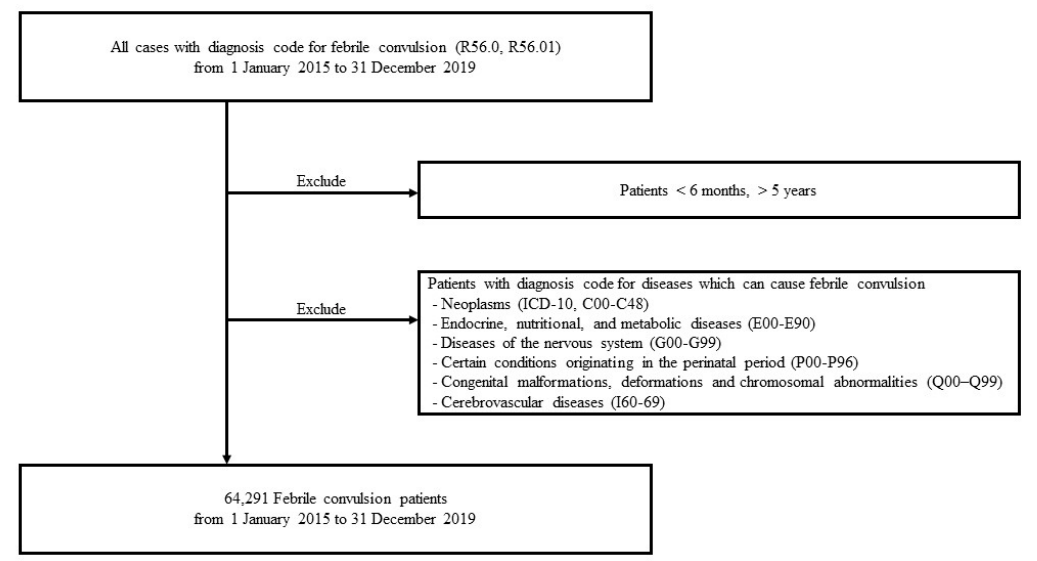
Figure 1. Flowchart illustrating patient selection.